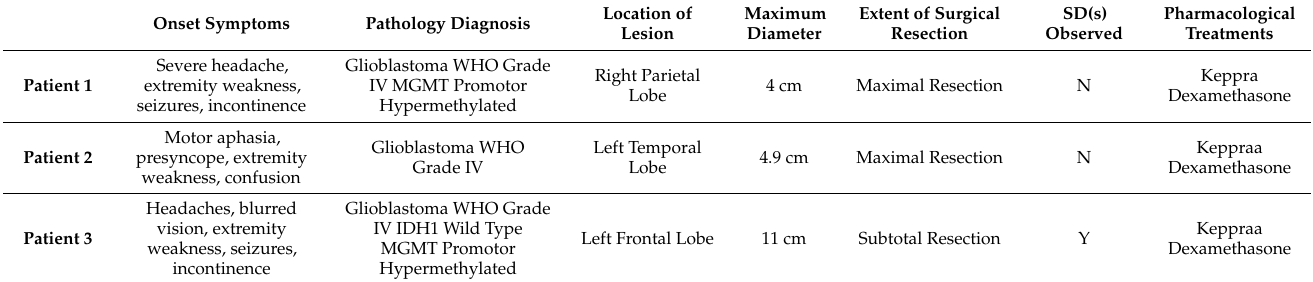
Table 1. Summary of clinical presentation. Onset symptoms were recorded prior to surgical inter- vention. Doses of pharmacological treatments increased from initial presentation to time of surgical intervention for two of the